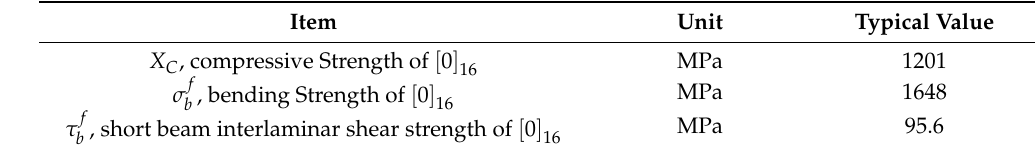
Table 3. Other mechanical properties of